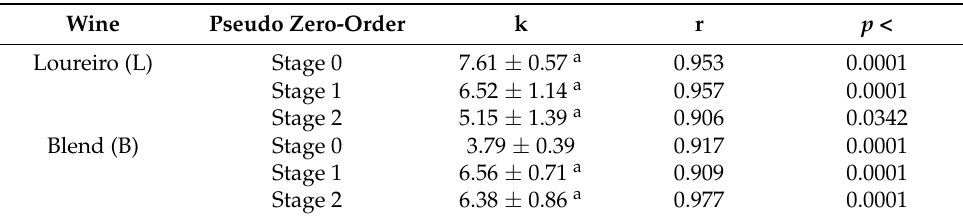
Table 6. Kinetic model for total phenols of the Loureiro monovarietal and Blend wine before and after